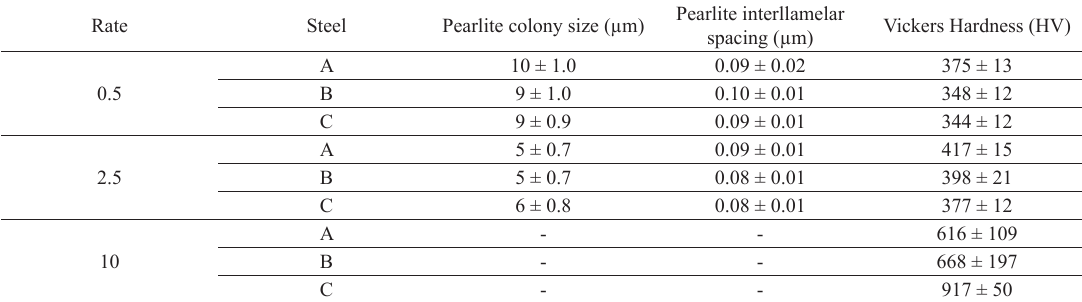
Pearlite interllamelar Vickers Hardness (HV) spacing (µm)